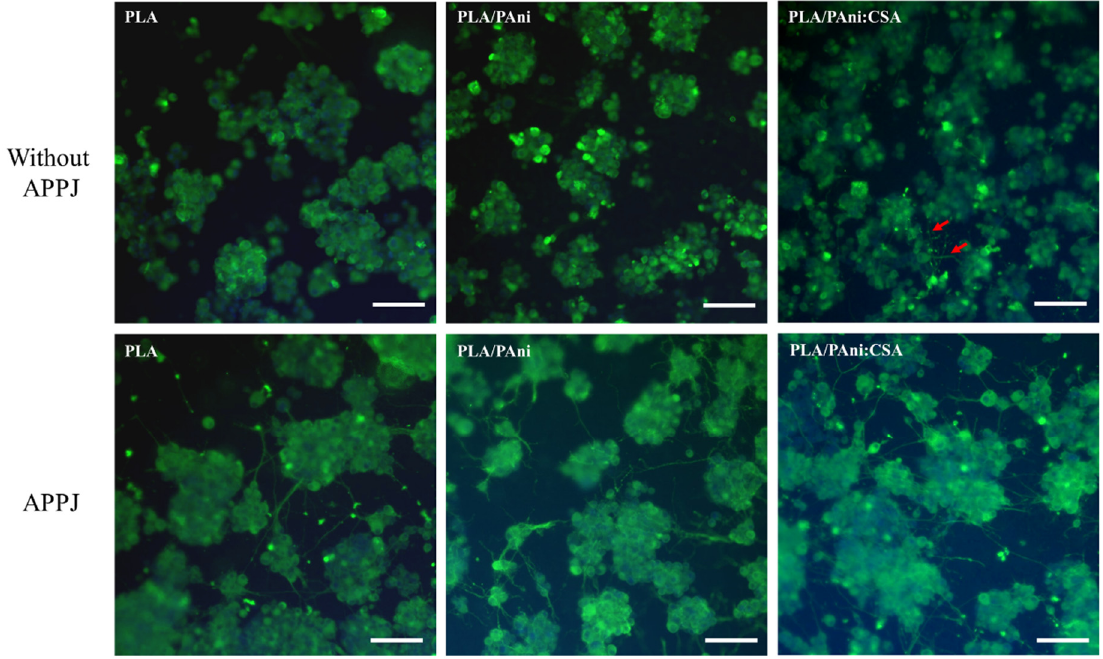
Figure 10. Representative immunofluorescent images of PC ‐ 12 cells cultured on DBD ‐ treated and APPJ/DBD ‐ treated PLA, PLA/PAni and PLA/PAni:CSA nanofibers for 10 days (Scale bar: 100 μ m).